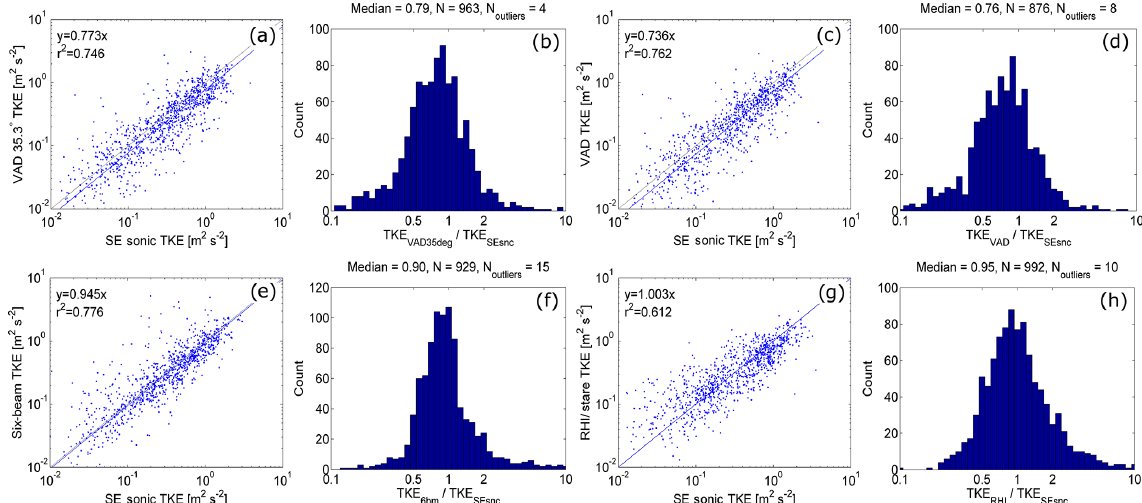
Figure 5. Scatterplots (a, c, e, g) and histograms (b, d, f, h) showing the relationship between the TKE measured by the lidar and southeast sonic anemometers at all heights. In (a) , (c) , (e) , and (g) , the blue line is the best fit line given by the equation in the upper left and the black line indicates a one to one relationship. Histograms (b, d, f, h) show the ratio of the lidar-measured TKE to the sonic-measured TKE with the median ratio, number of points N, and number of outliers N outliers that are more than 1 order of magnitude apart. Lidar measurements are from TKE at φ = 35 . 3 ◦ (a, b) , TKE from two φ (c, d) , the six-beam technique (e, f) , and the RHI and stare combination (g, h) .